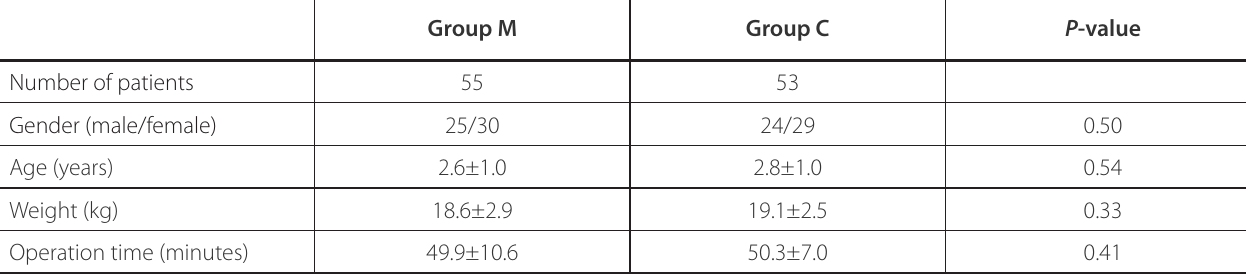
Table 1 . Demographic and clinical characteristics of the two